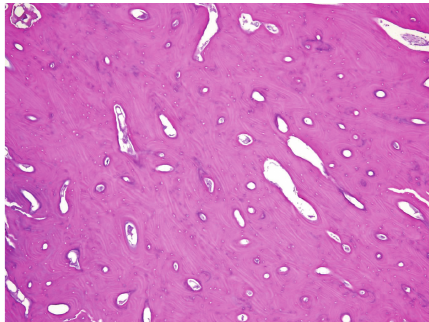
Figure 4: Histological examination shows that the tissue consists of dense sclerotic lamellar